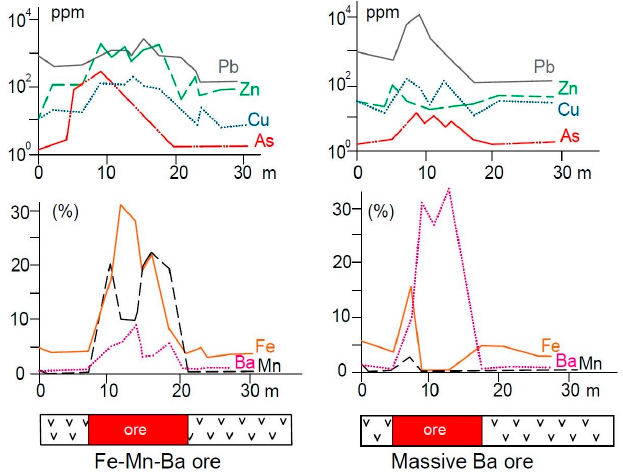
Figure 7. Variation in the concentrations of some elements in two sections crossing the Fe-Mn-Ba and Ba ores at Tumanpınarı.